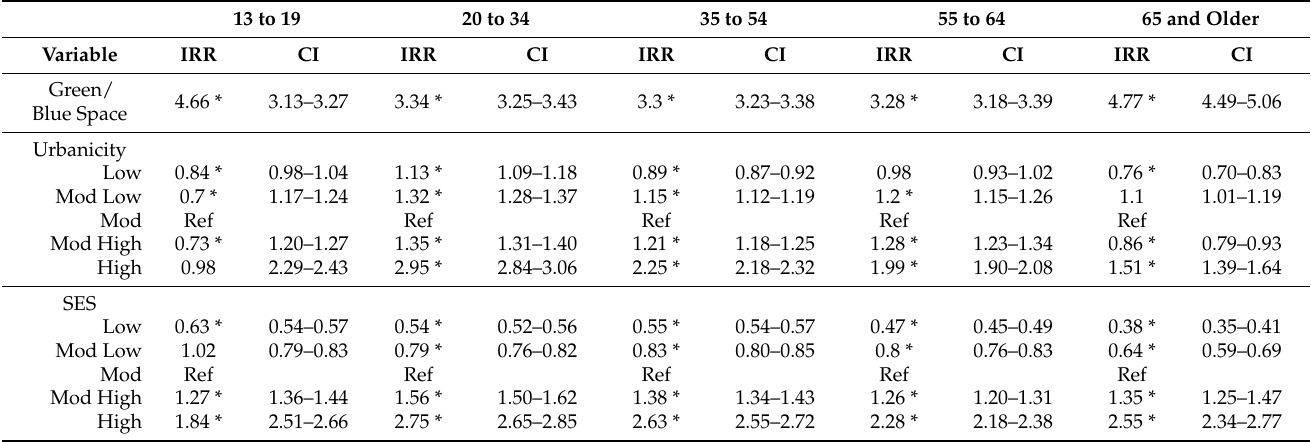
Table 4. Strava Runners by Age